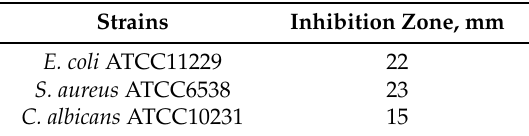
Table 1. Antibacterial activity of AgCl-NPs in 2.5 mg/mL